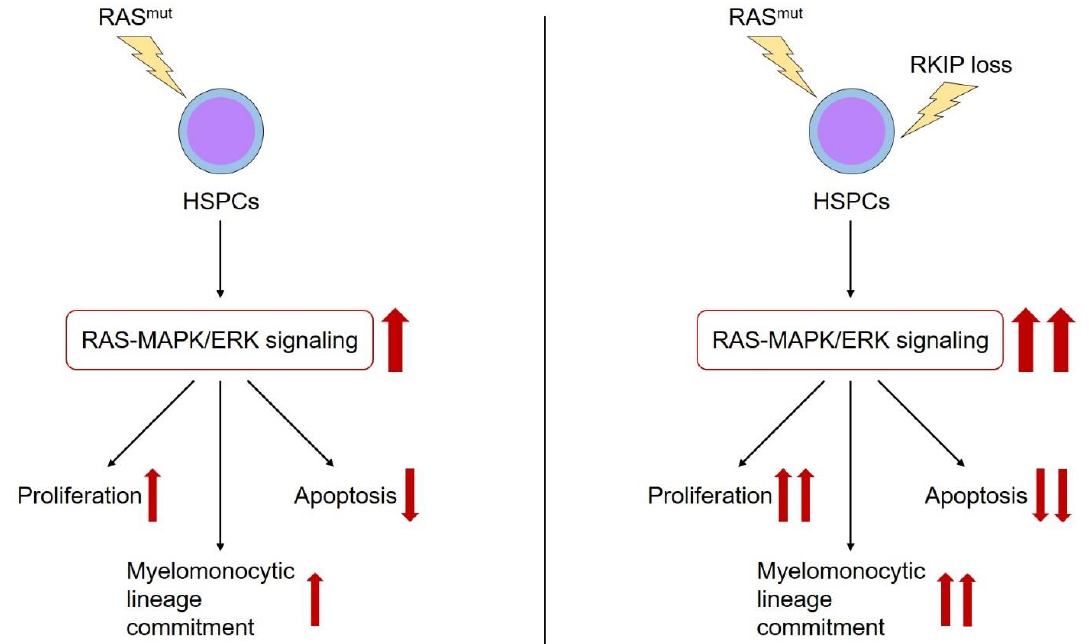
Figure 2. The role of RKIP in myeloid leukemogenesis. RAS-signaling mutations (RAS mut ) are essential genetic aberrations during the leukemic transformation of HSPCs. Among other effects, they activate the RAS-MAPK/ERK signaling cascade, which in turn i) increases the proliferation, ii) reduces the apoptosis, and iii) induces the myelomonocytic lineage commitment of HSPCs (red arrows). Additional occurrence of RKIP loss has been shown to aggravate the effects of RAS-signaling mutations on these properties (red arrows).